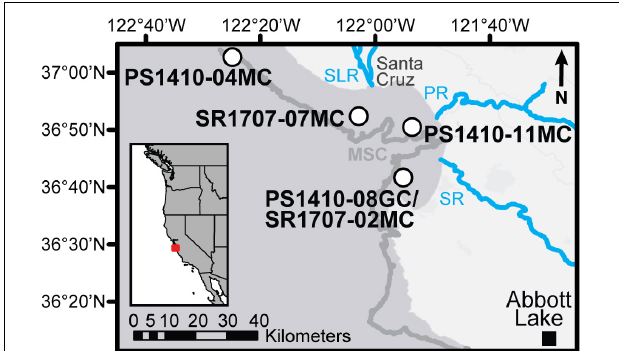
FIGURE 1 | Map of the Monterey Bay study area. Core locations are shown as white dots, note that PS1410-08GC and SR1707-02MC were collected from the same location. The three major rivers draining into Monterey Bay (SLR – San Lorenzo River, PR – Pajaro River, and SR – Salinas River) are shown in blue. The 100 m isobath offshore is shown with the gray line, along with the location of the Monterey Submarine Canyon (MSC). The black square shows the location of Abbott Lake within the Salinas River watershed from which a regional hydroclimate record was utilized (Hiner et al.,